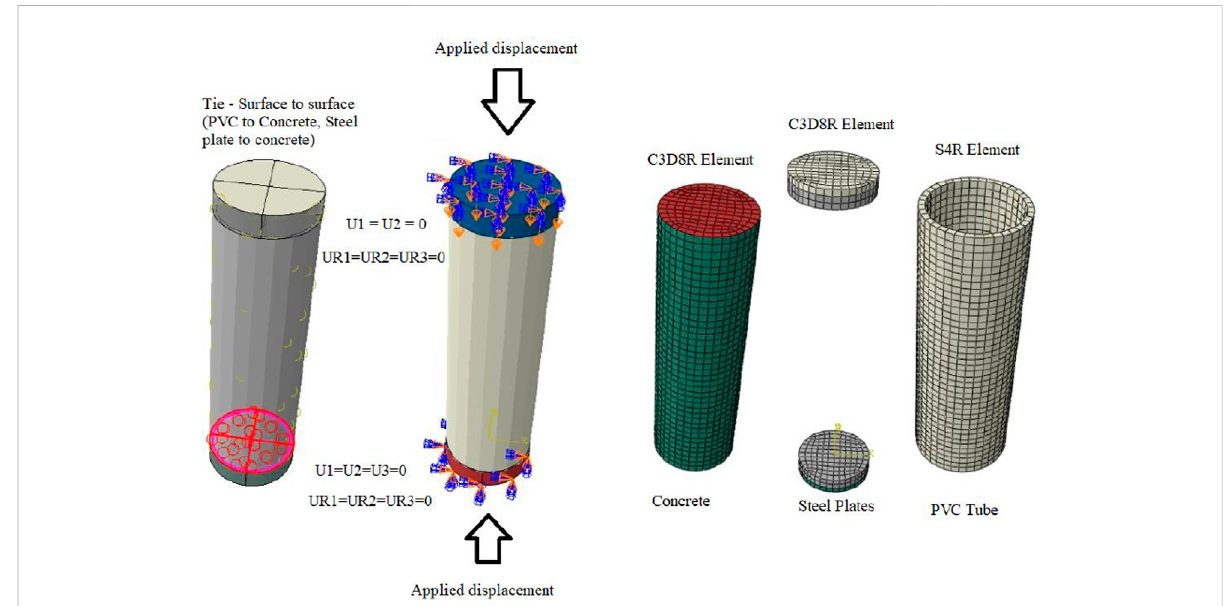
FIGURE 5 Finite element type, loading conditions, boundary conditions and contact surface for CFPT